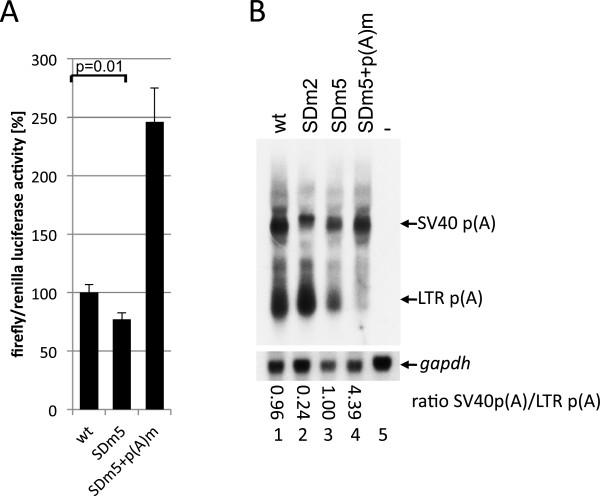
Regulation of polyadenylation is independent of splicing. (A) Luciferase assay of BHK-21 cells transfected with pGL3 derivatives. The cleavage and polyadenylation are suppressed by the splicing-incompetent SDm5 mutant. The significances of the reductions by the MSD mutations were calculated by paired two-sample t-test. p-value is indicated. (B) Northern blotting of RNA from BHK-21 cells transfected with pCMVTas and the pGL3 derivatives detected with a probe encompassing nucleotides +1 to +250. Ratios of transcripts uncleaved/cleaved at the LTR polyadenylation site are shown below the Northern blot.